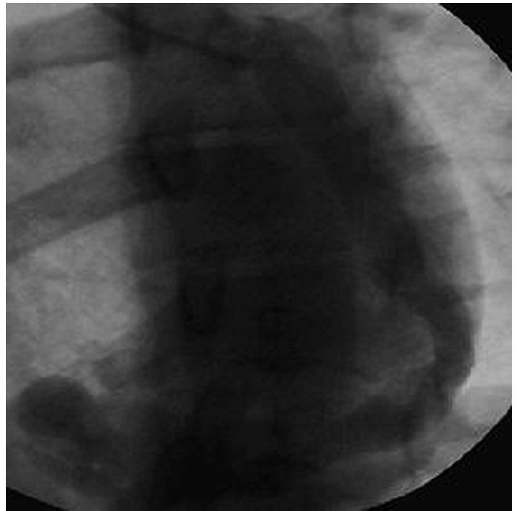
Figure 2 - Coronary angiography revealing a markedly dilated tortuous circumflex coronary artery connected to the right ventricle, indicating a coronary artery